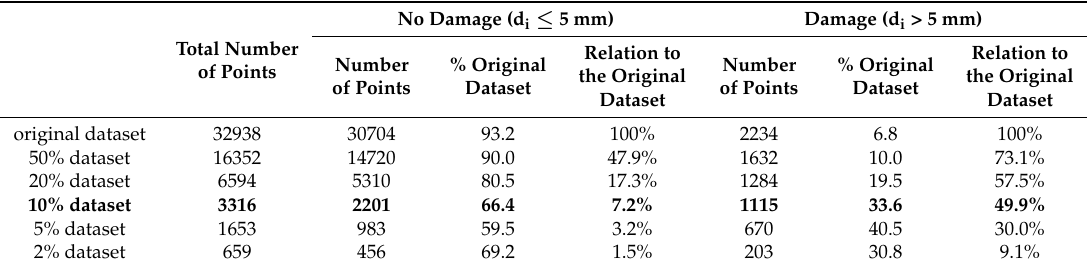
Table 2. Results of processing with the random method—concrete